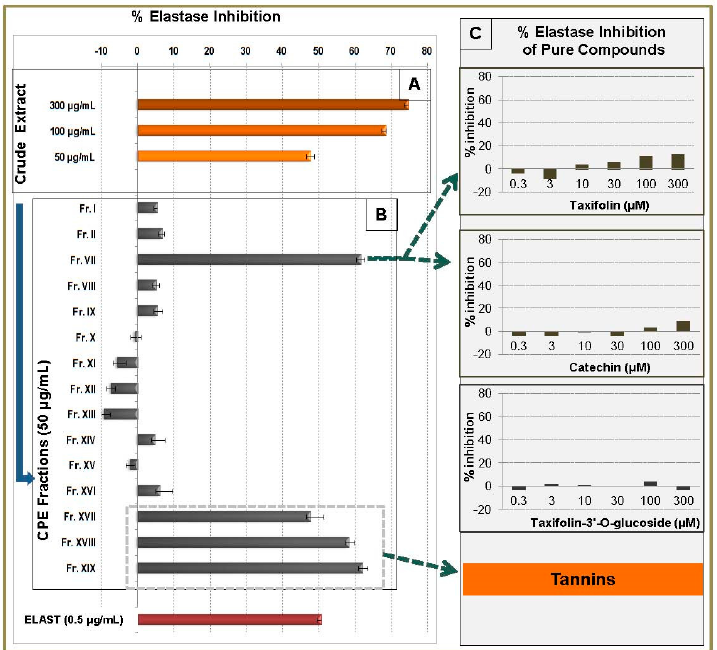
Figure 4. Elastase inhibitory activity of methanol bark extract, CPC fractions and pure compounds. ( A ) % inhibition activity of crude extract at 300, 100 and 50 μ g/mL, ( B ) % inhibition activity of CPC fractions at 50 μ g/mL and ( C ) % inhibition activity of pure taxifolin, catechin and taxifolin-3 ′ - O - glucoside in six concentrations (0.3, 3,10, 30, 100 and 300 μ M). Positive control: Elastatinal (ELAST) at 0.5 μ g/mL.